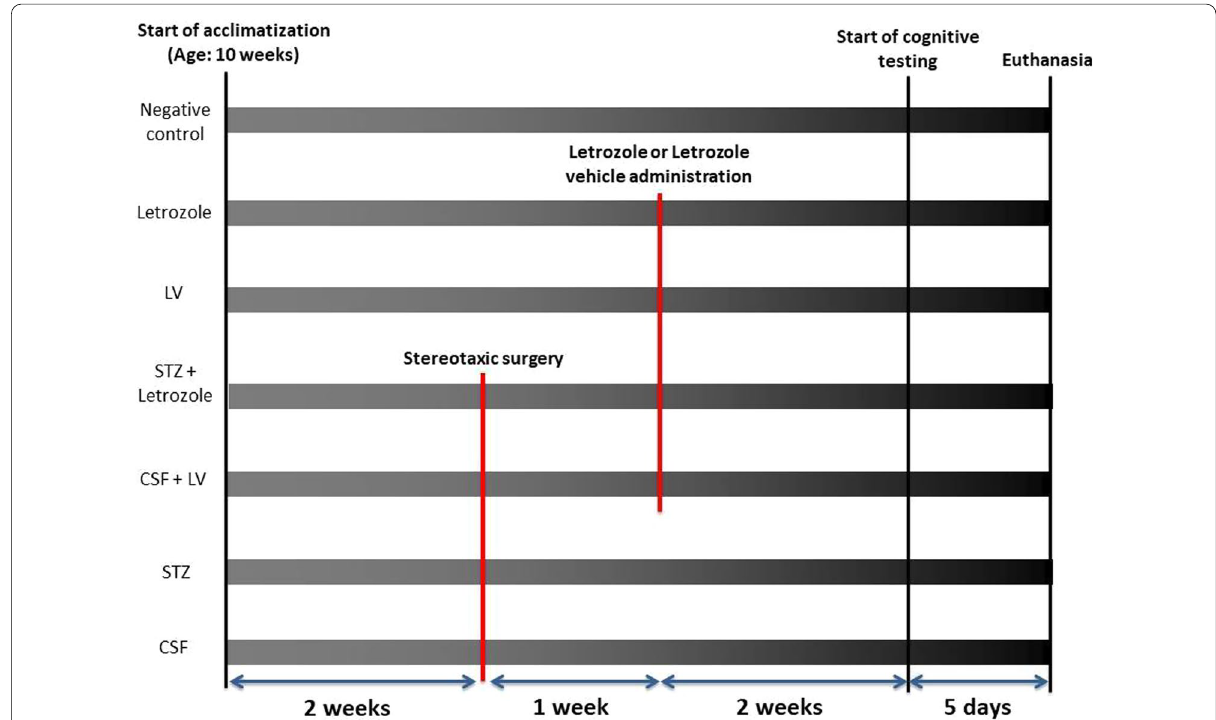
Fig. 1 Timeline of animal experiments. Briefly, following a 2‑week acclimatization period, animals were randomly divided into seven groups: Negative control, Letrozole, Letrozole Vehicle (LV), STZ, CSF Control, STZ Letrozole, and CSF Letrozole Vehicle (CSF LV) Control. The + + + experimental time frame was 26 days from the experimental starting point, at which the stereotaxic surgery was performed on the STZ, CSF Control, STZ Letrozole, and CSF LV groups, to the animal euthanasia point, at which hippocampal samples were + +